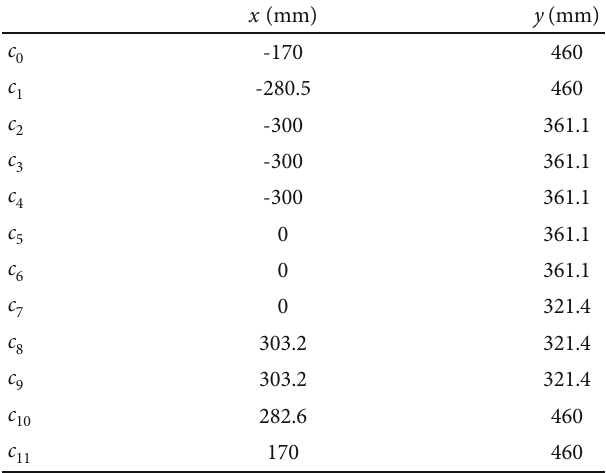
Z Figure 5: X HipR HipR -plane workspace point map.